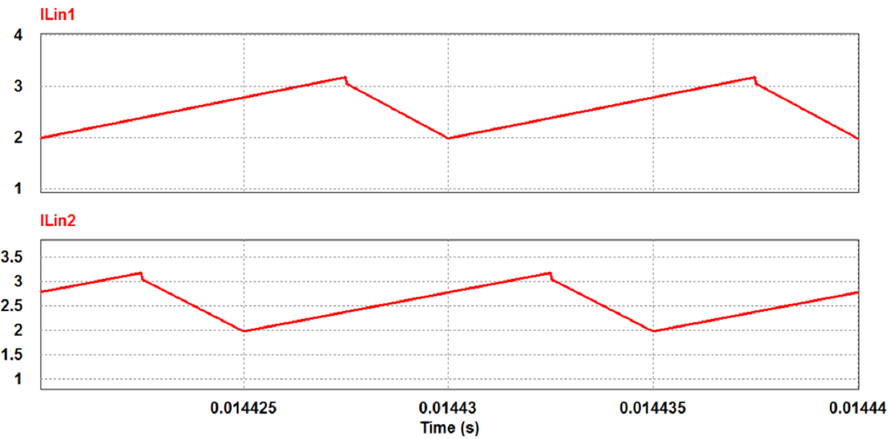
Figure 11. Inductor currents ( I Lin 1 , I Lin 2